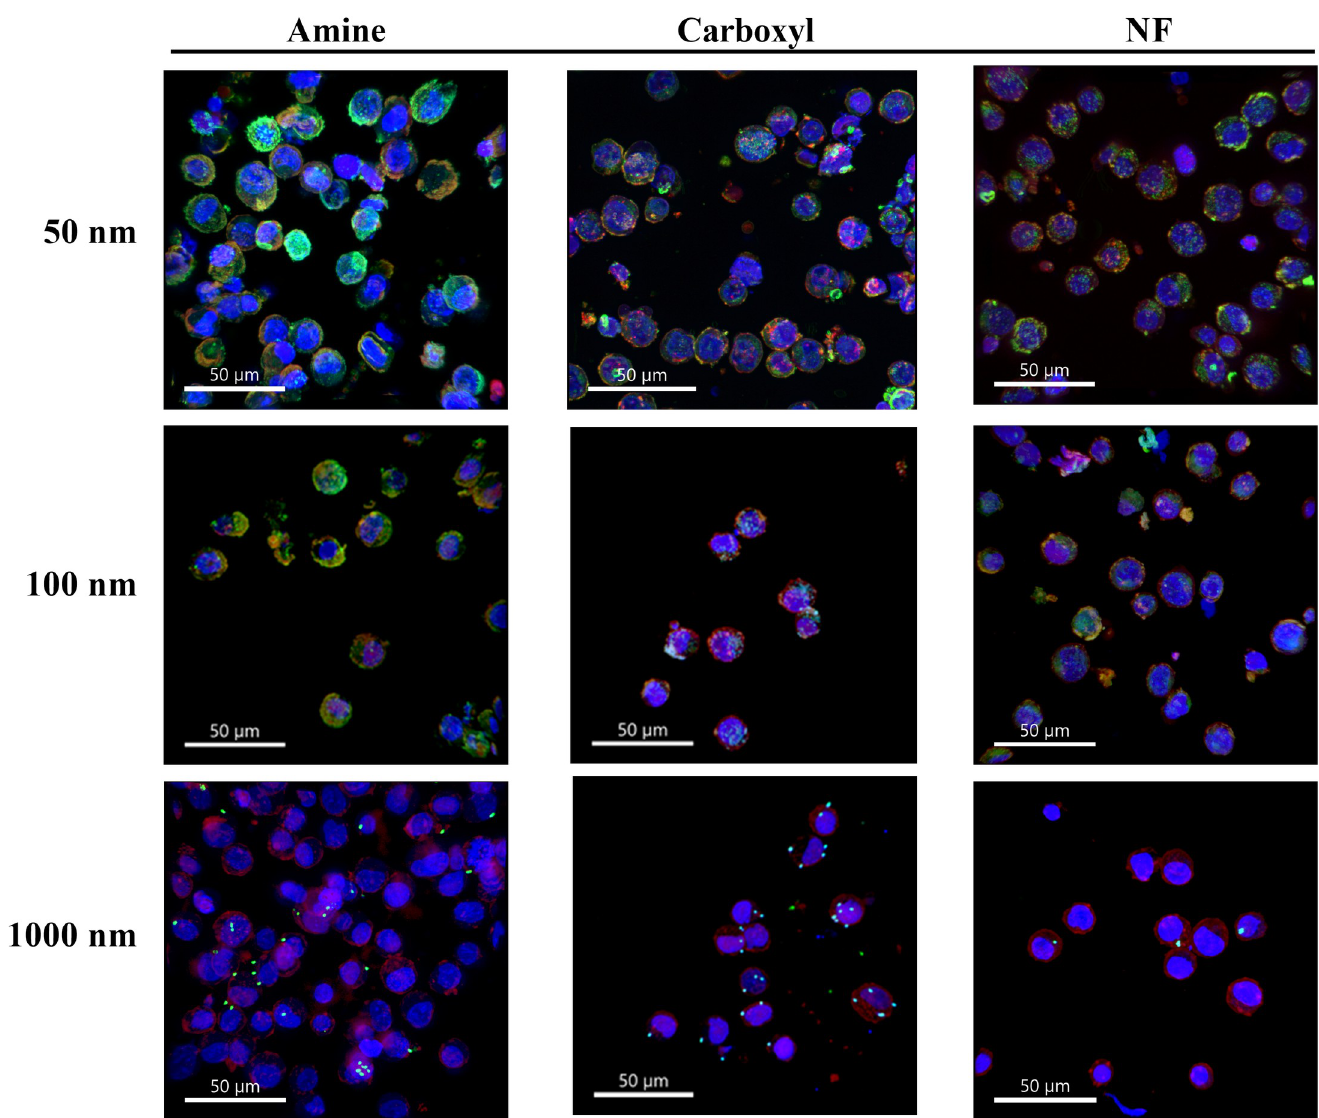
Fig 2. Confocal microscopy images of cells after treatment with polystyrene particles. Representative confocal laser scanning microscopy images of SNU-1 cells after treatment with 50, 100 or 1000 nm aminated, carboxylated or NF particles for 4 h. An overlay of blue representing nuclear stain, red representing cell membrane stain, and green representing MP/NP particles, is provided. All images were taken at 40X magnification and a scale bar of 50 μ m was used.